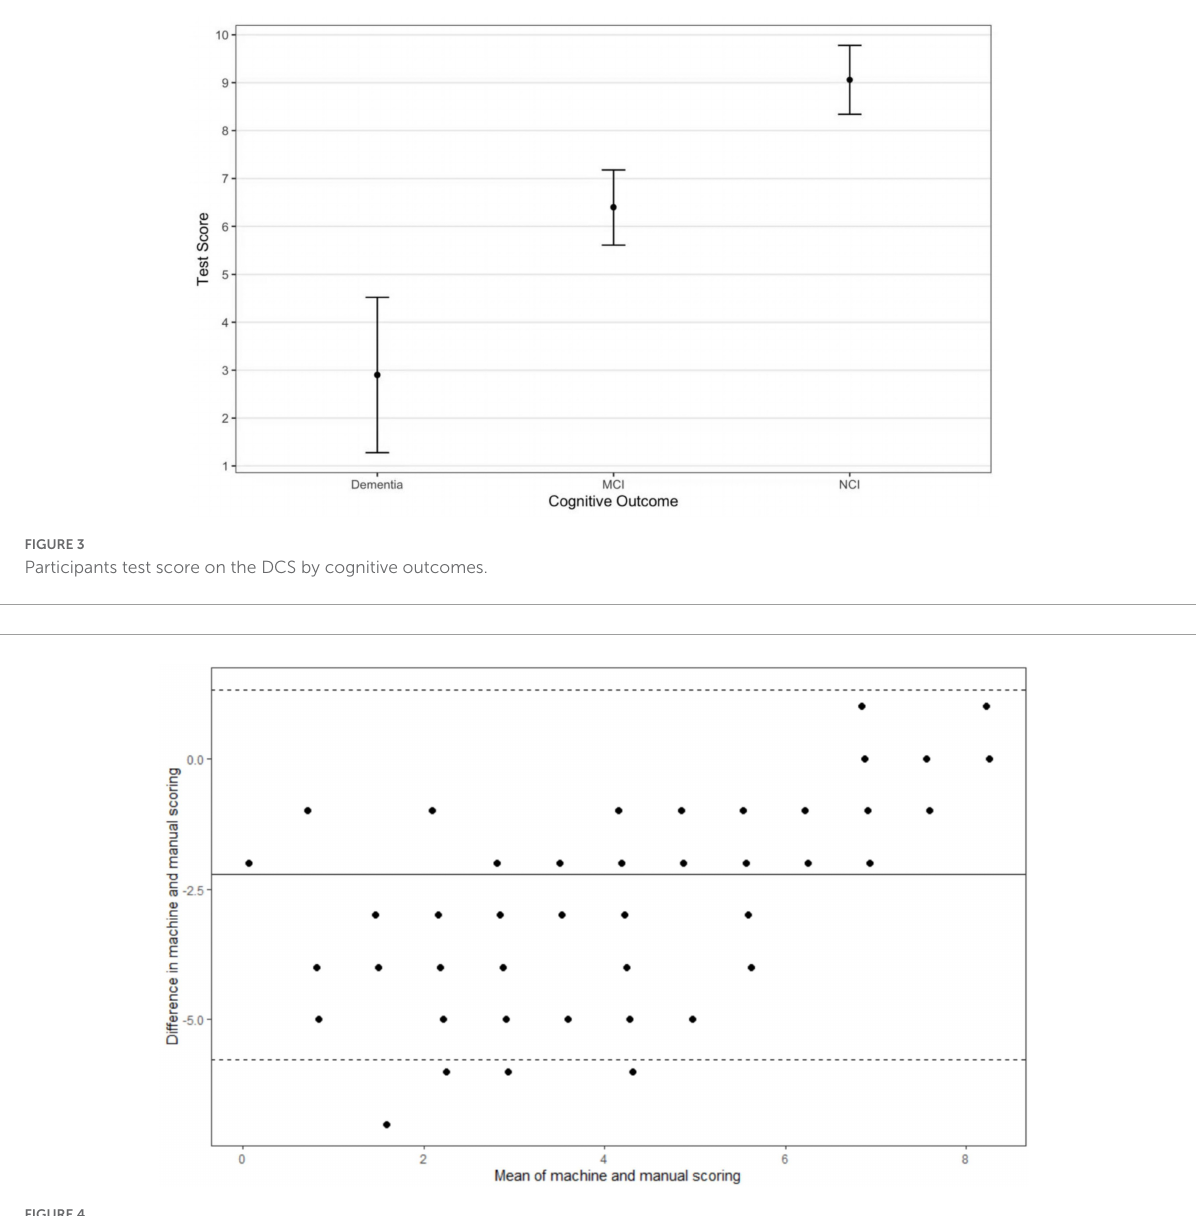
FIGURE4 Bland-Altman plot of machine and manual